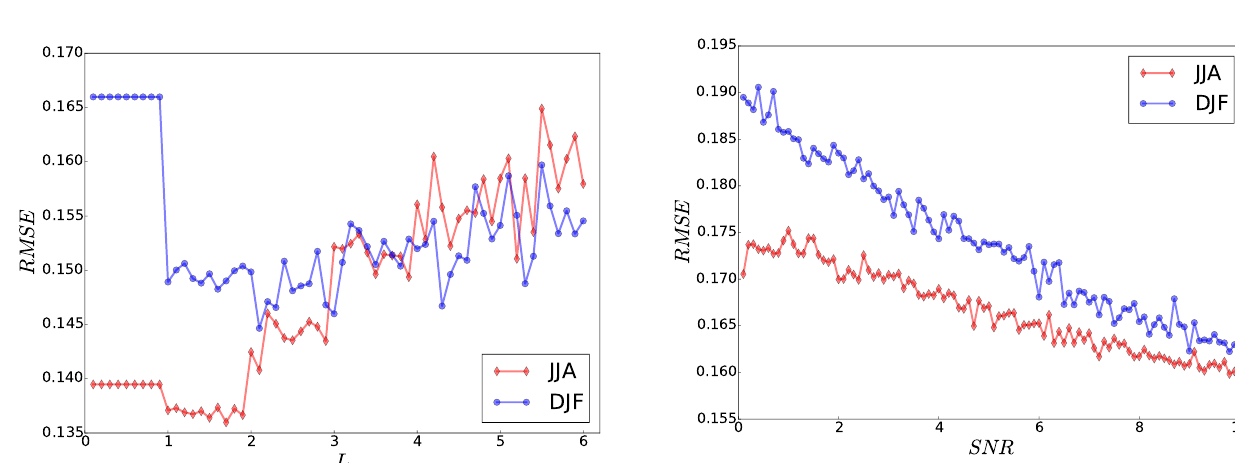
Figure 2. 10-year ensemble spread and RMSE for the seasonal mean of 2m temperature (K).